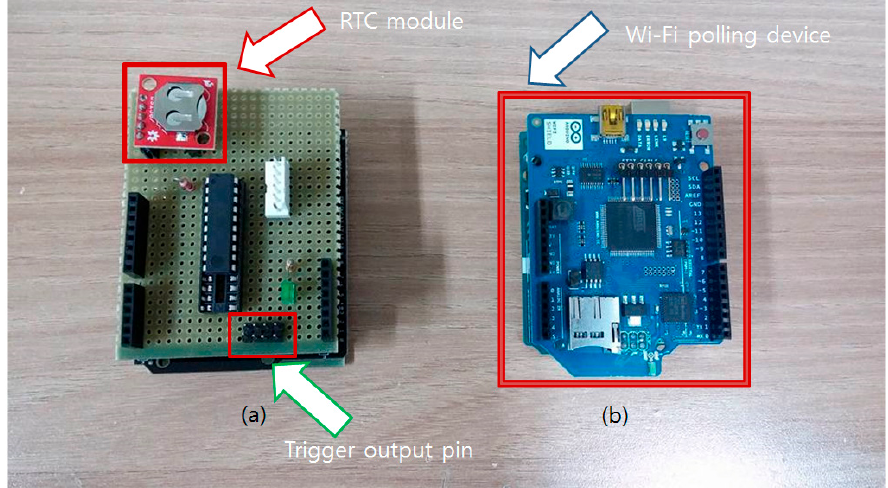
Figure 8. Developed on-line/off-line polling devices. ( a ) The off-line RTC-based polling device is shown at the left side. Red arrow indicates that the RTC generates 1Hz wave for the time counting. Pinouts pointed by the green arrow are trigger output pins when the timer reaches the given time; ( b ) The blue board at the right side is a network time-based on-line polling device. Blue arrow shows a Wi-Fi shield that enables access to the time server.